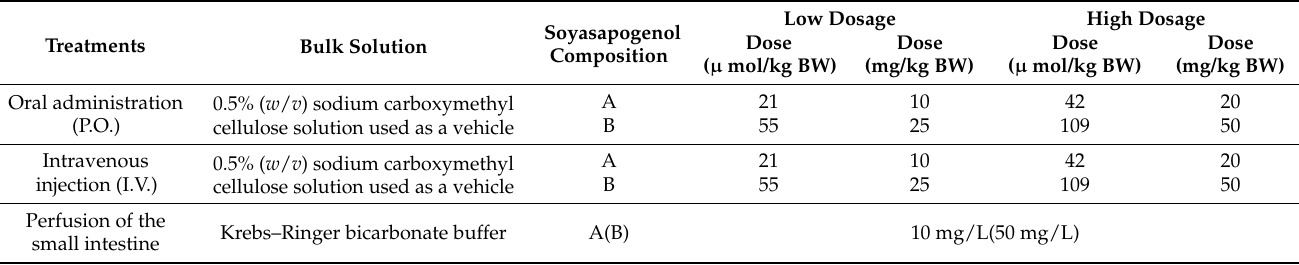
Table 5. Dose and composition of the tested samples in each treatment